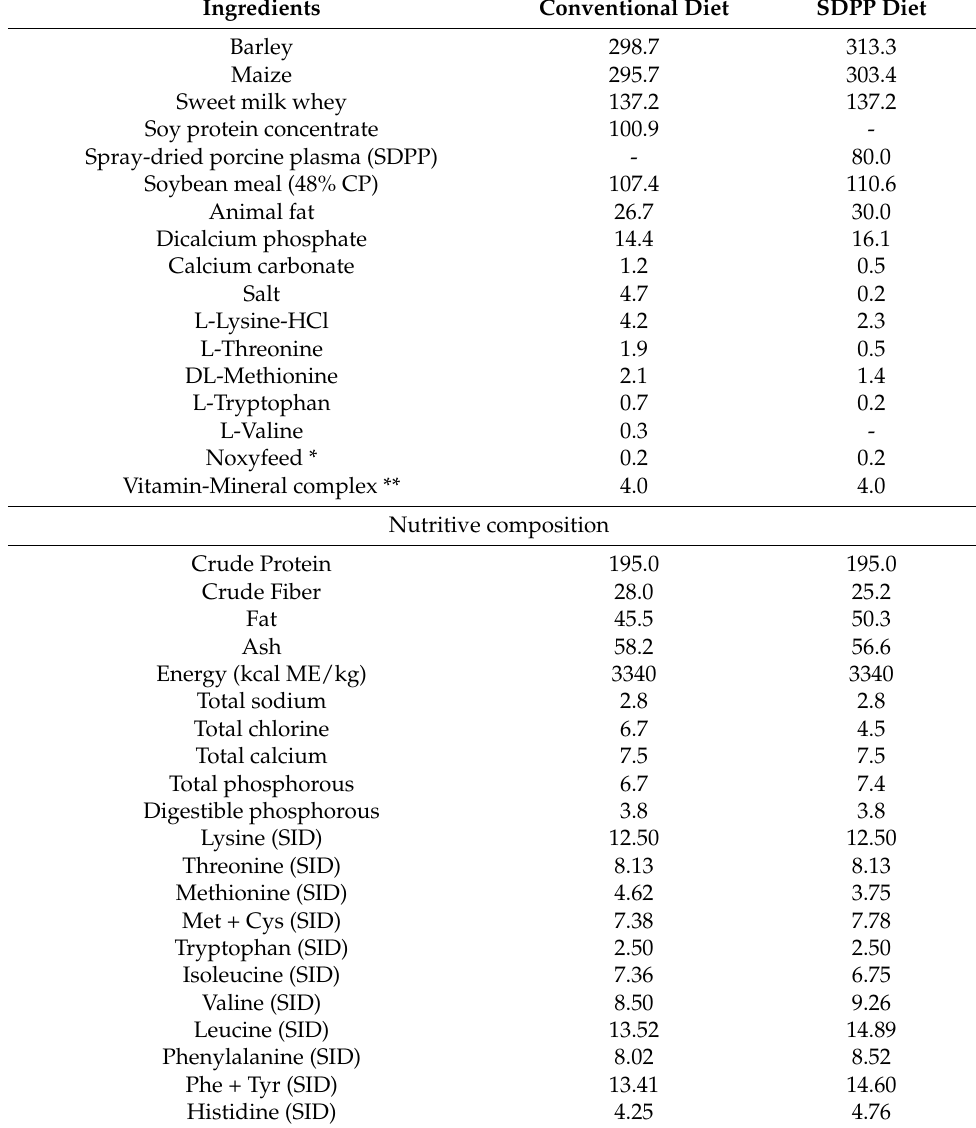
Table 1. Composition and estimated nutritive composition of the basal experimental diet (g/kg